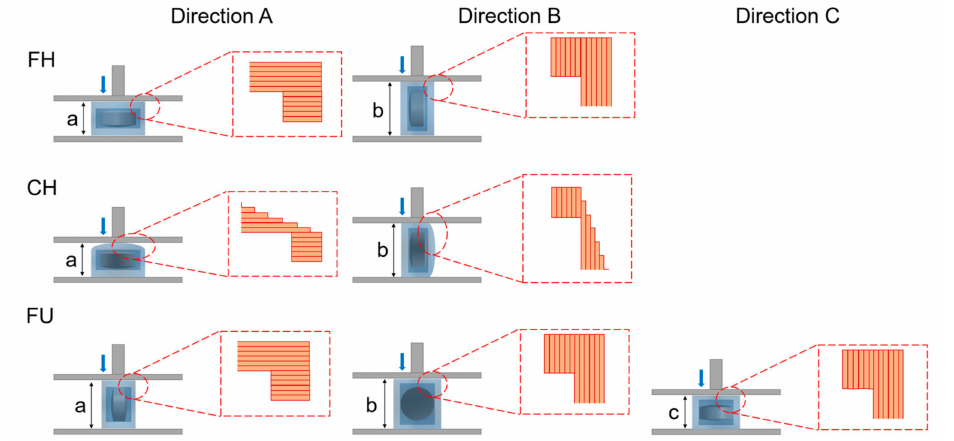
Figure 3. Illustration of the hardness testing in directions ( A ) force was added parallelly to the hight of tablet (a), ( B ) force was added parallelly to the diameter/major axis of tablet (b), and ( C ) force was added parallelly to the minor axis of tablet